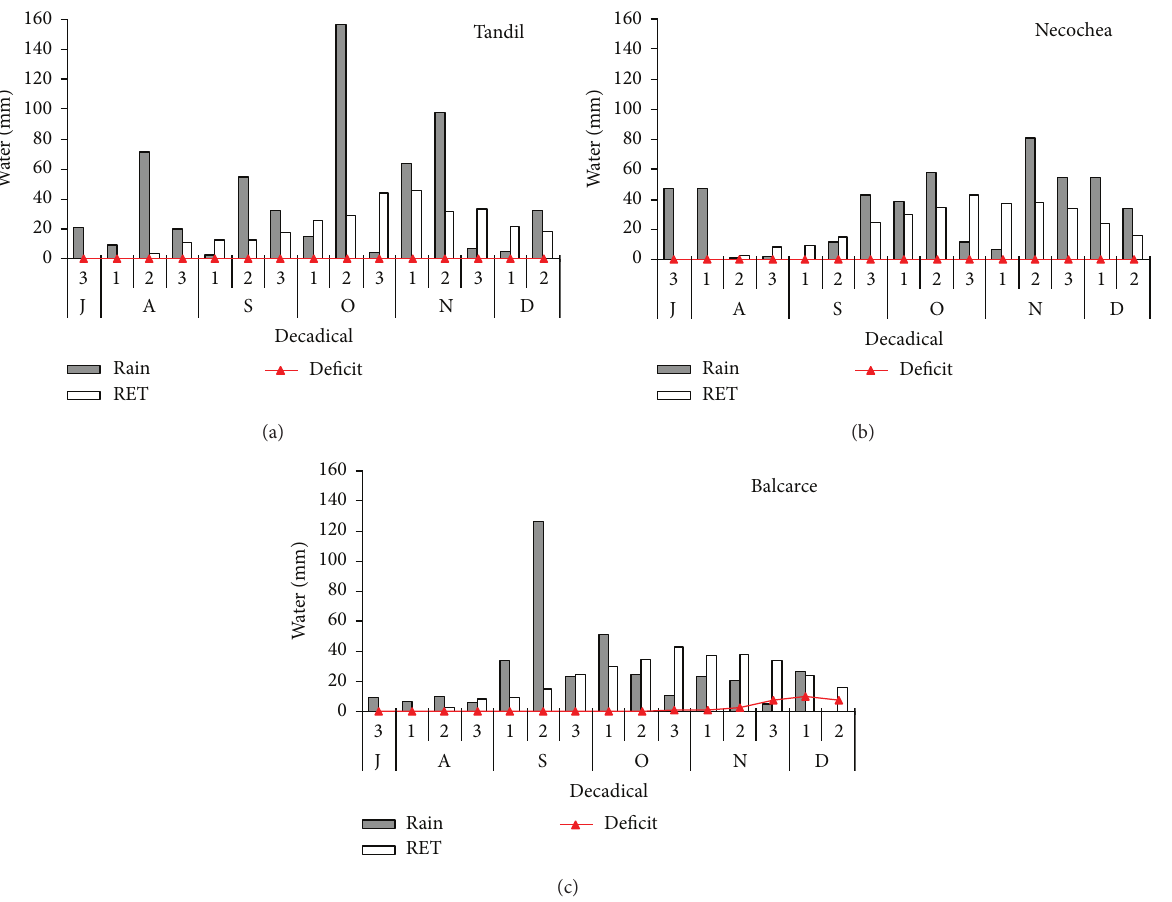
Figure 2: Precipitation, real evapotranspiration (RET), and water deficit during wheat growing season at Tandil, Necochea, and Balcarce